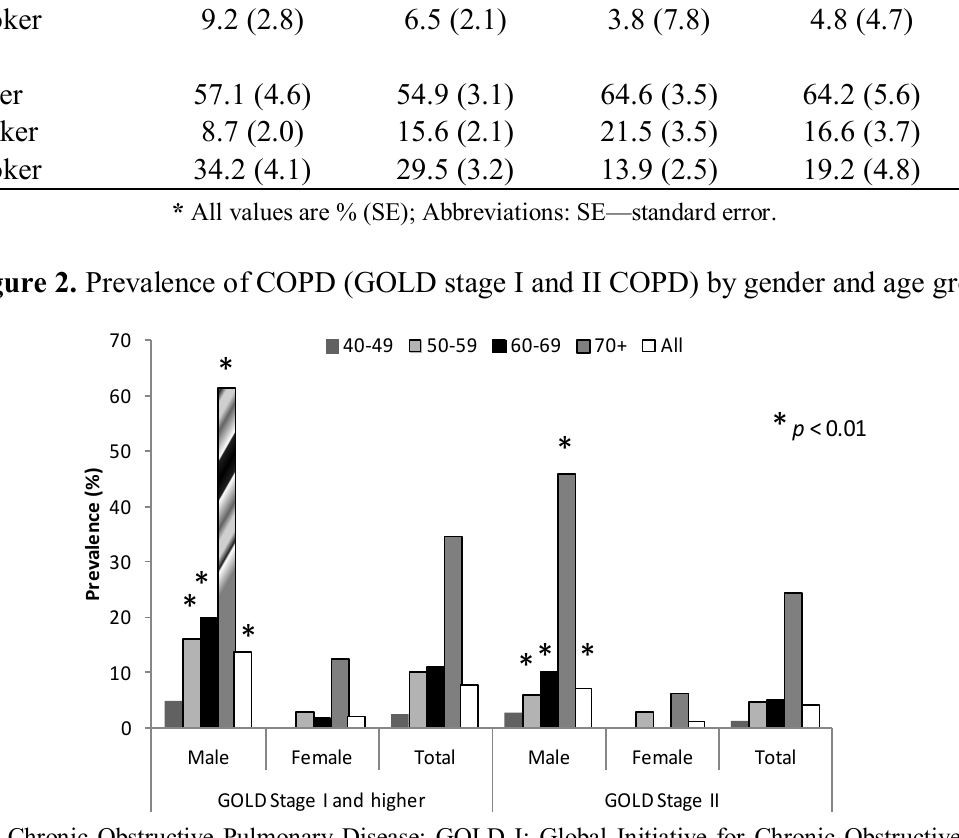
COPD: Chronic Obstructive Pulmonary Disease; GOLD I: Global Initiative for Chronic Obstructive Lung Disease Stage I COPD; GOLD II: Global Initiative for Chronic Obstructive Lung Disease Stage II COPD; * p < 0.01, significant difference between men and women according to